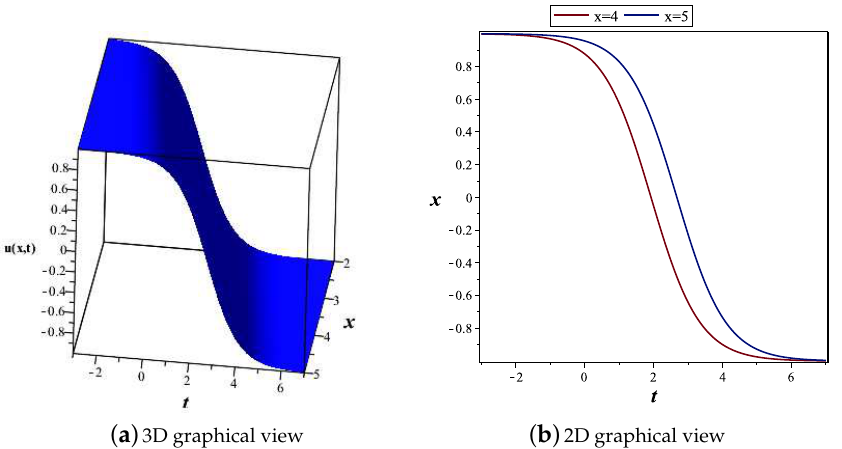
Figure 5. Graphical representation of Equation (39) within interval 2 ≤ x ≤ 5 and − 3 ≤ t ≤ 7 (( a ) 3D plot, ( b ) 2D plot for t = 4,